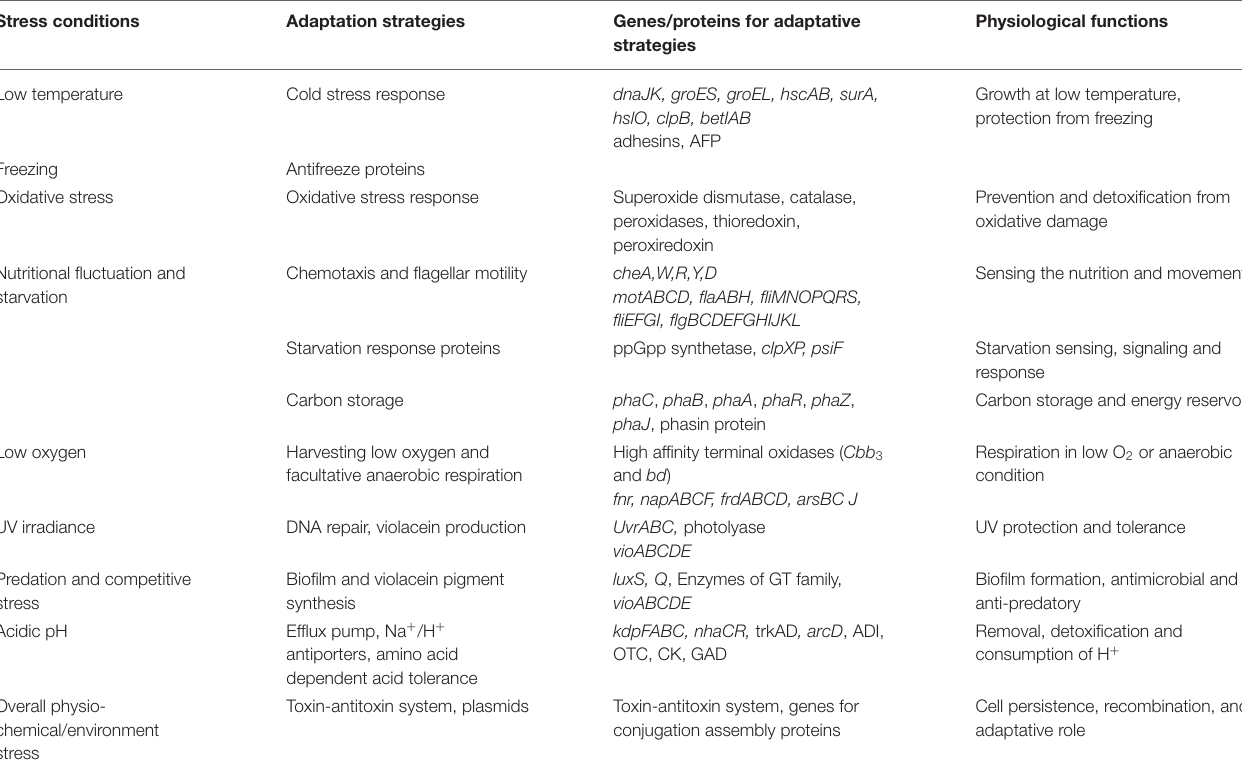
TABLE 2 | Adaptive genomic traits of Iodobacter sp. PCH194. Adaptive strategies to stress conditions and related genes/proteins are tabulated along with their putative physiological and ecological